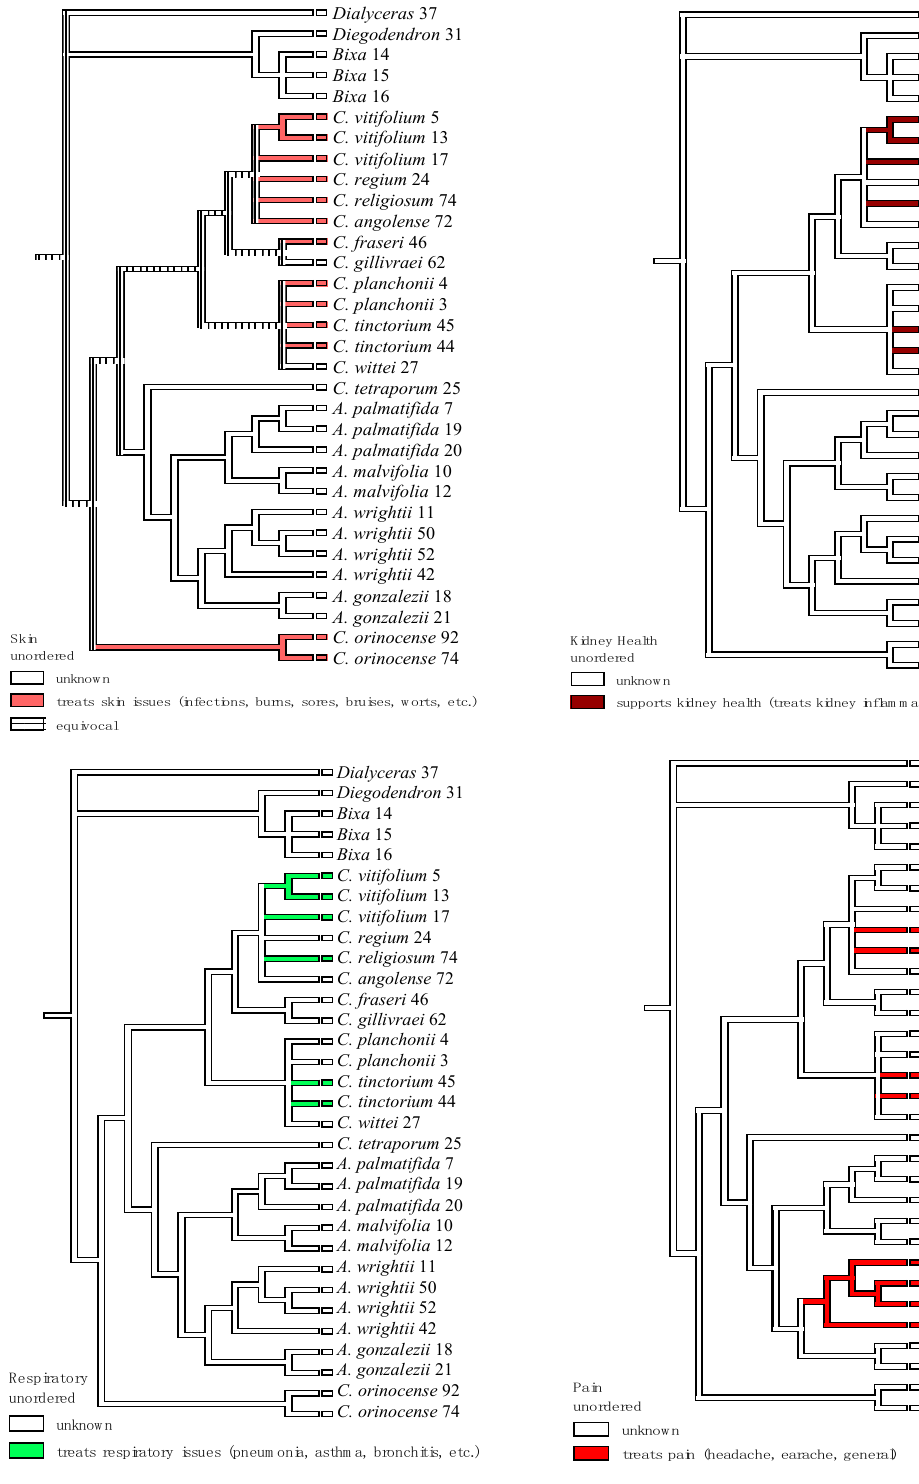
Figure 10. Medicinal uses (treatments for skin, kidney, and respiratory ailments and general pain) shared by two or more species mapped (as unordered character states) onto the Bayesian inference phylogeny of Cochlospermaceae of the combined nuclear (ITS) and plastid ( trnG and trnL-F ) regions from Johnson-Fulton and Watson [35].